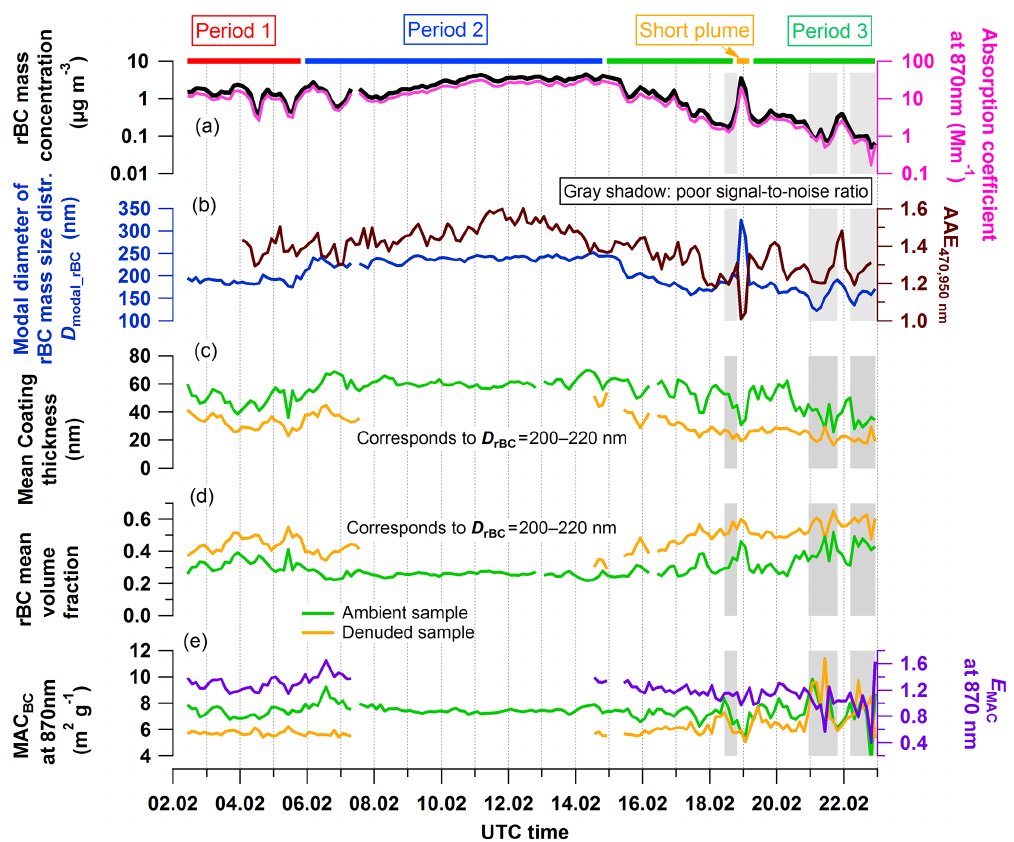
Figure 5. Time series of the physical and optical parameters of BC in the dried aerosol sample at 3h time resolution: (a) ambient rBC mass concentration measured by SP2 (left axis) and absorption coefficient of bulk aerosol measured by PAX at 870nm (right axis); (b) model BC core diameter of rBC mass size distributions determined with lognormal fits shown in Fig. S6 (left axis) and AAE 470 , 950 (right axis); (c) mean thickness of non-BC coatings on ambient and denuded rBC cores with mass-equivalent diameters in the range 200 to 220nm, calculated from single-particle data; (d) mean rBC volume fractions for ambient and denuded rBC particles calculated from the coating thickness data shown in (c) ; (e) mean MAC BC of ambient and denuded samples (left axis) and corresponding E MAC calculated with Eq. (4) (right axis). The gap in the denuded time series in (c) and (d) (and corresponding gap in the E MAC time series in e ) from 6 to 14 February is due to malfunction of the valve-switching system. The time periods when rBC mass was less than 0.2µgm − 3 are marked with gray shading due to poor signal-to-noise